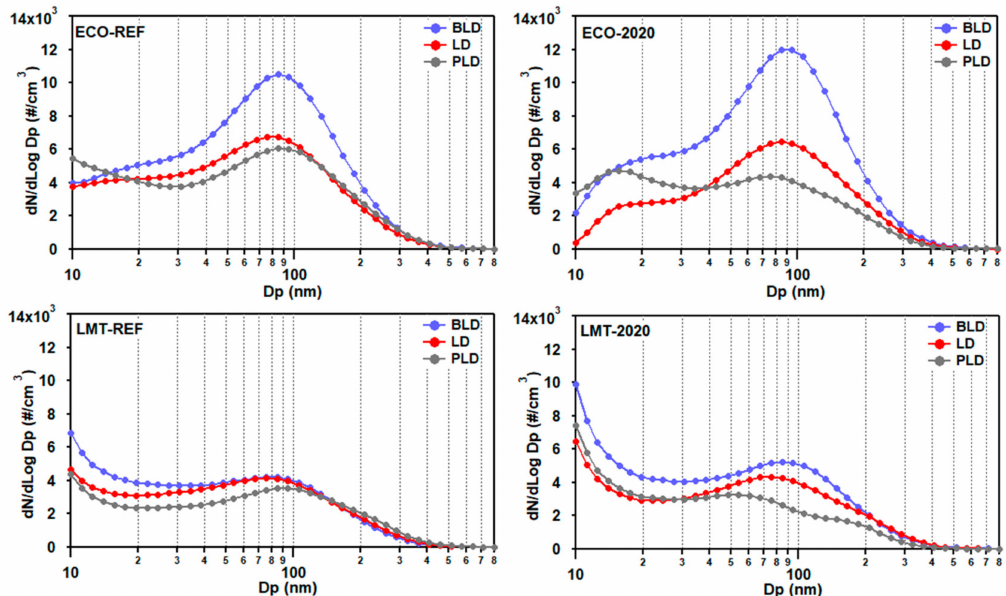
Figure 4. Particle number size distributions average during the three time windows over the reference (2015–2019) and 2020 years for both sites, ECO and